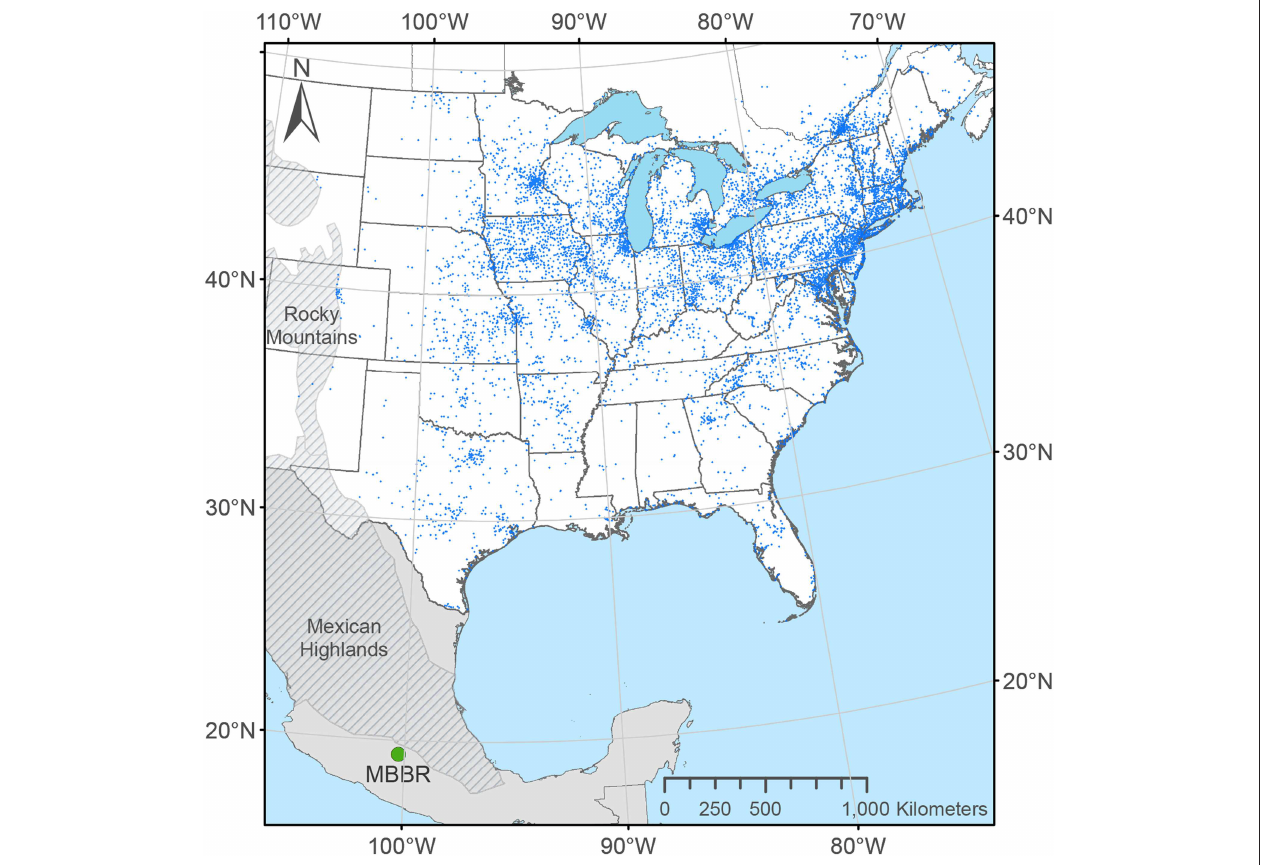
FIGURE 2 | Distribution of 8,389 unique locations where monarch butterflies were tagged east of the Rocky Mountains in the U.S. and Canada through the Monarch Watch program from 1998 to 2015. Each dot represents a unique location determined from geocoding place names of tagging effort provided by Monarch Watch